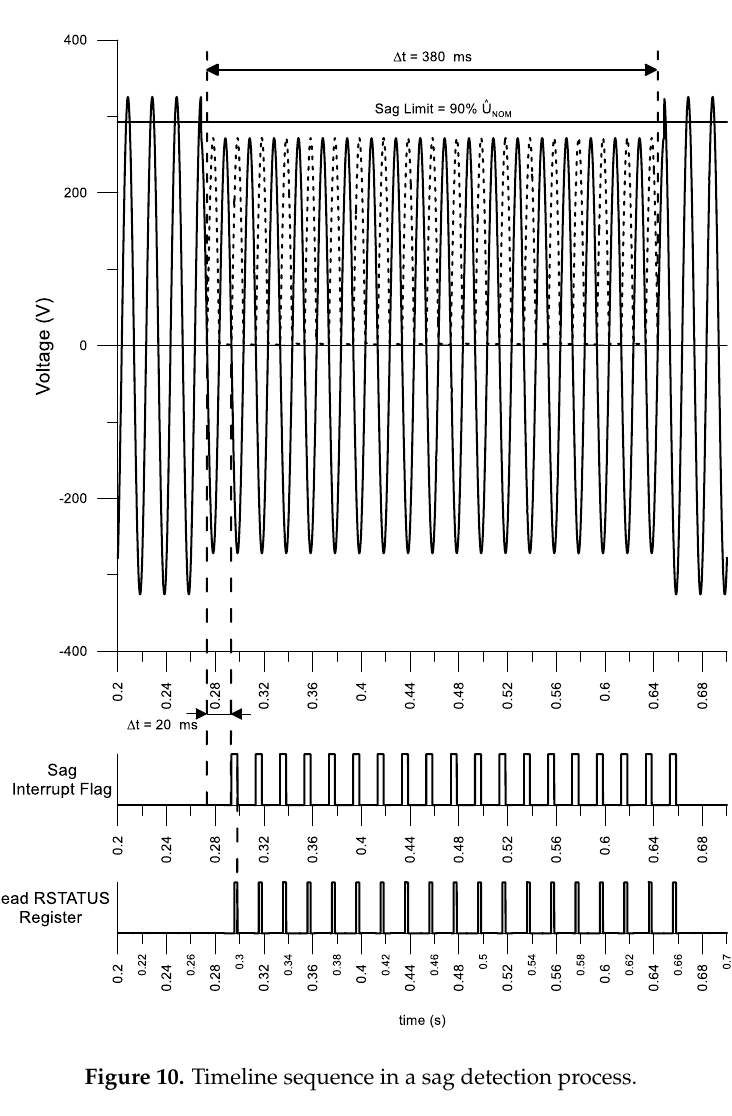
Figure 10. Timeline sequence in a sag detection process.